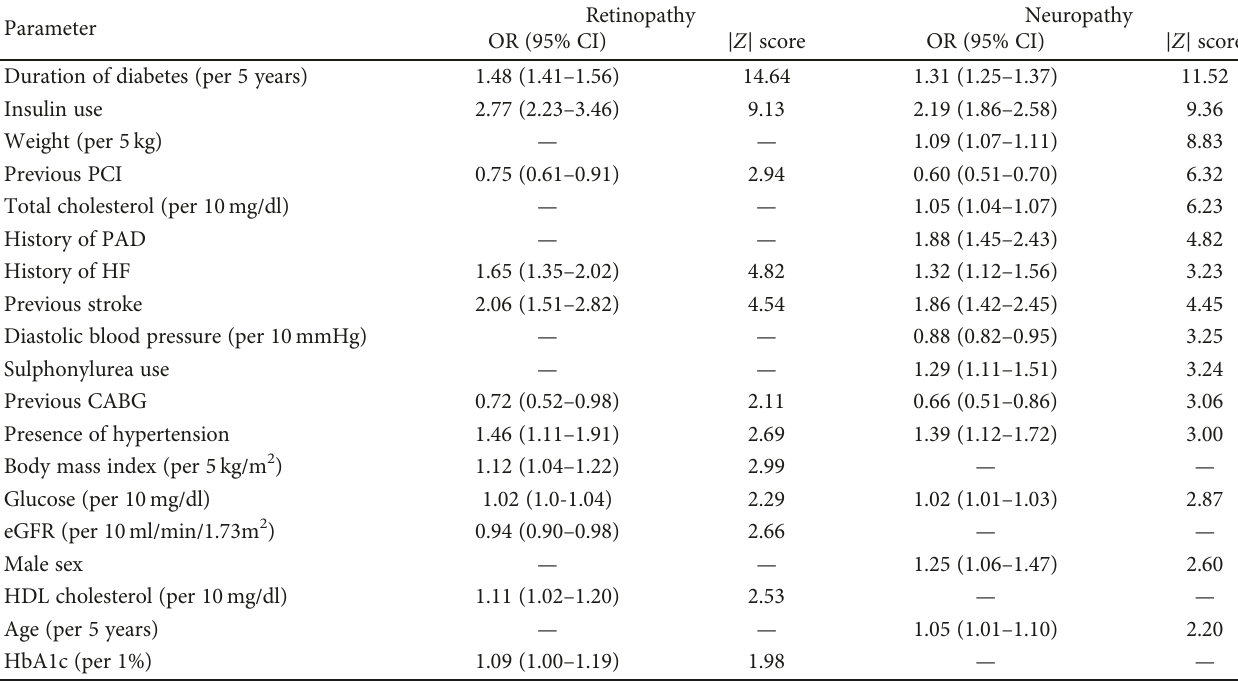
Table 3: Predictors of retinopathy and neuropathy multivariate